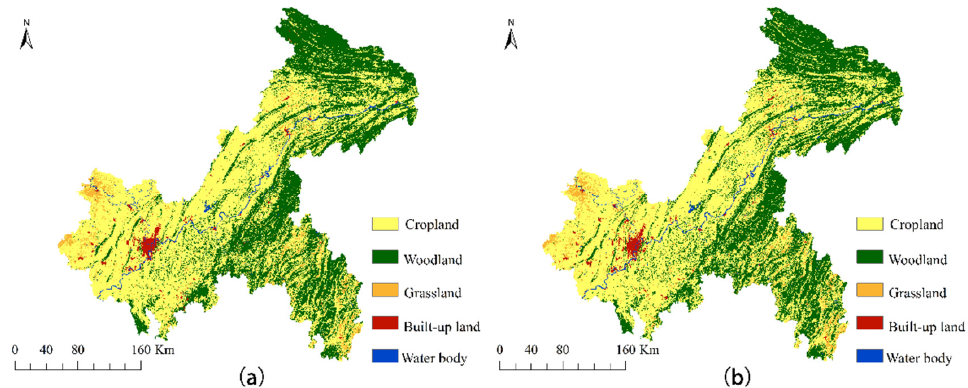
Figure A1. Comparison between the simulated ( a ) and actual land use map ( b ) in 2015.